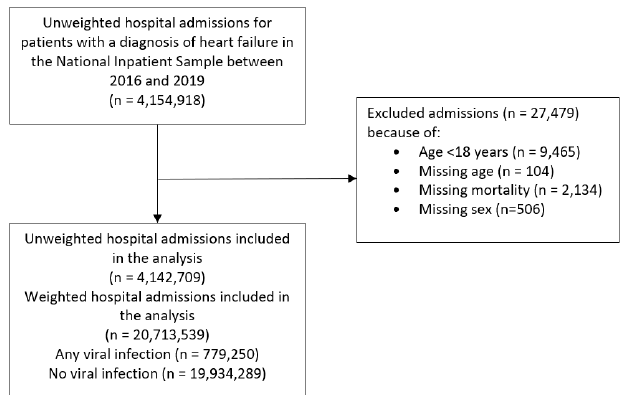
Figure A1. Flow diagram of hospital admissions with heart failure included in the analysis.